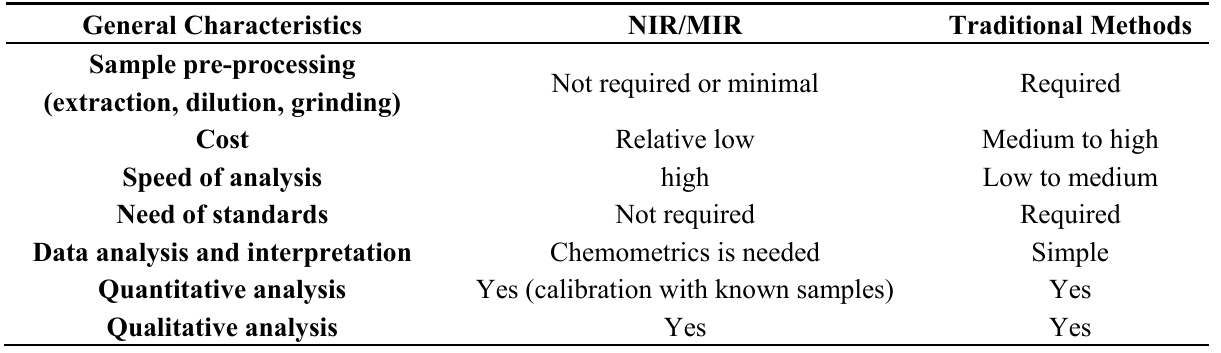
Table 1. Advantages and disadvantages of near infrared (NIR) and mid infrared (MIR) compared with traditional